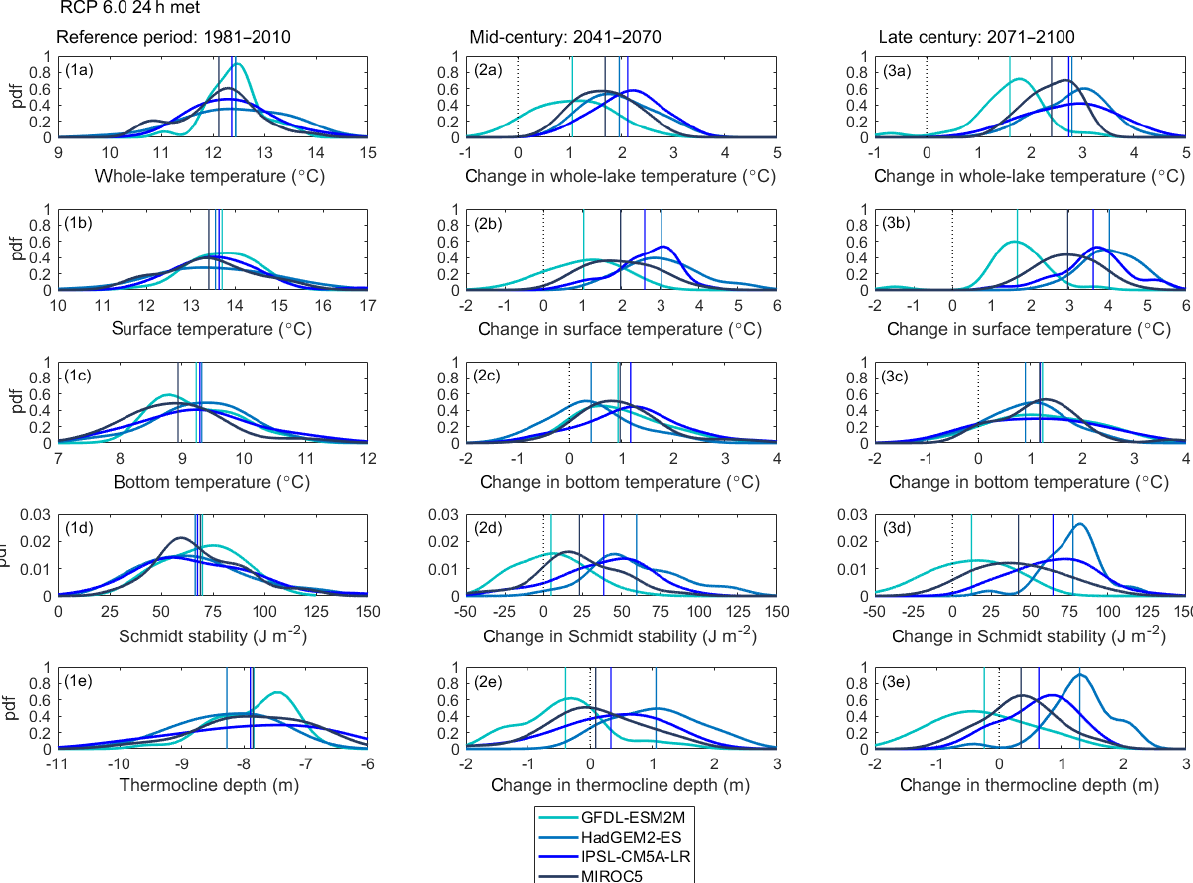
Figure 6. Changes in annually averaged thermal metrics (from April to September) for (2a, 3a) whole-lake temperature, (2b, 3b) surface temperature, (2c, 3c) bottom temperature, (2d, 3d) Schmidt stability, and (2e, 3e) thermocline depth under RCP6.0 and showing results from when the lake model was forced with daily GFDL–ESM2M, HadGEM2–ES, IPSL–CM5A–LR, and MIROC5 projections. All changes for the mid-century (2041–2070) and the late century (2071–2100) are relative to the reference period (1981–2011). The mean (vertical line) is also shown. Changes in thermal metrics greater than 0 show an increase and lower than 0 show a